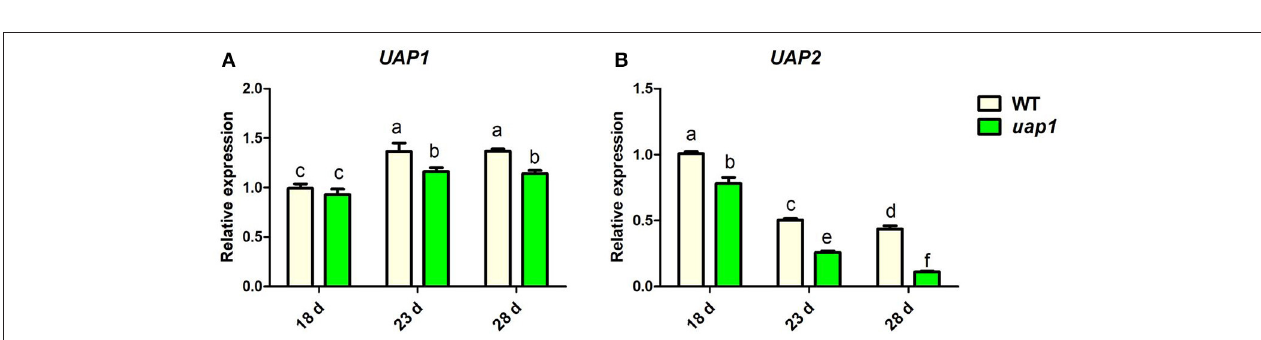
FIGURE 3 | Relative expression of UAP genes in wild-type and uap1 mutant leaves. (A) The UAP1 gene. (B) The UAP2 gene. Leaf samples in 18-, 23-, and 28-day-old plants at the seedling stage were detected (corresponding to Figure 1A ). Relative expression of genes by qRT-PCR is normalized with reference genes UBC , Profilin-2, and Actin1 . All data represent the mean ± SD of three biological replicates, and lowercase letters above columns indicate the statistically significant difference among all samples (one-way